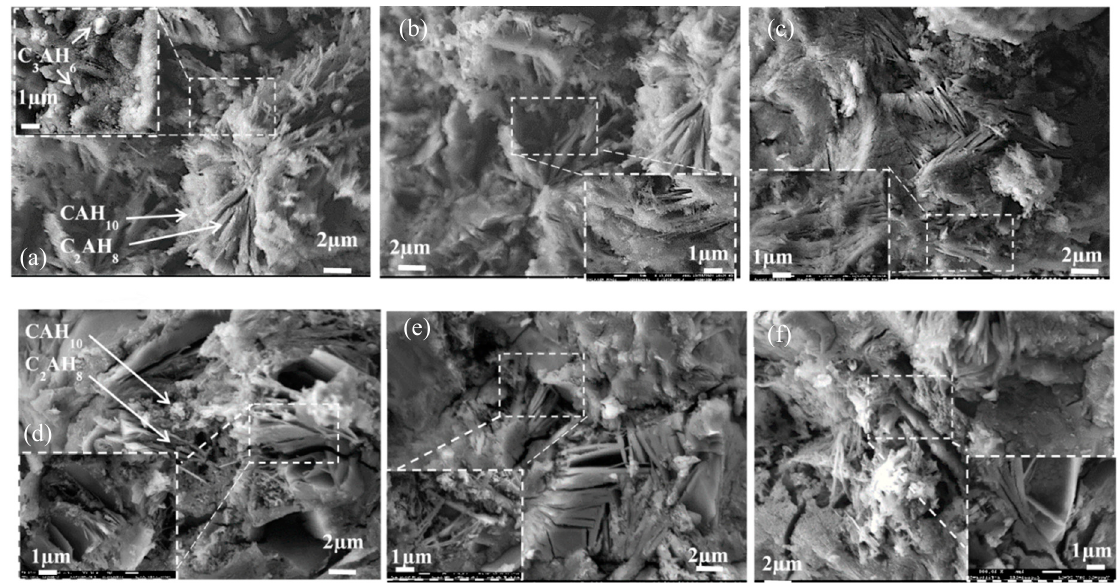
Figure 6. The microstructure images of samples after 3 days of hardening. ( a )—GNS1; ( b )—GNS2; ( c )—GNS3; ( d) —GNC1; ( e )—GNC2; ( f )—GNC3.